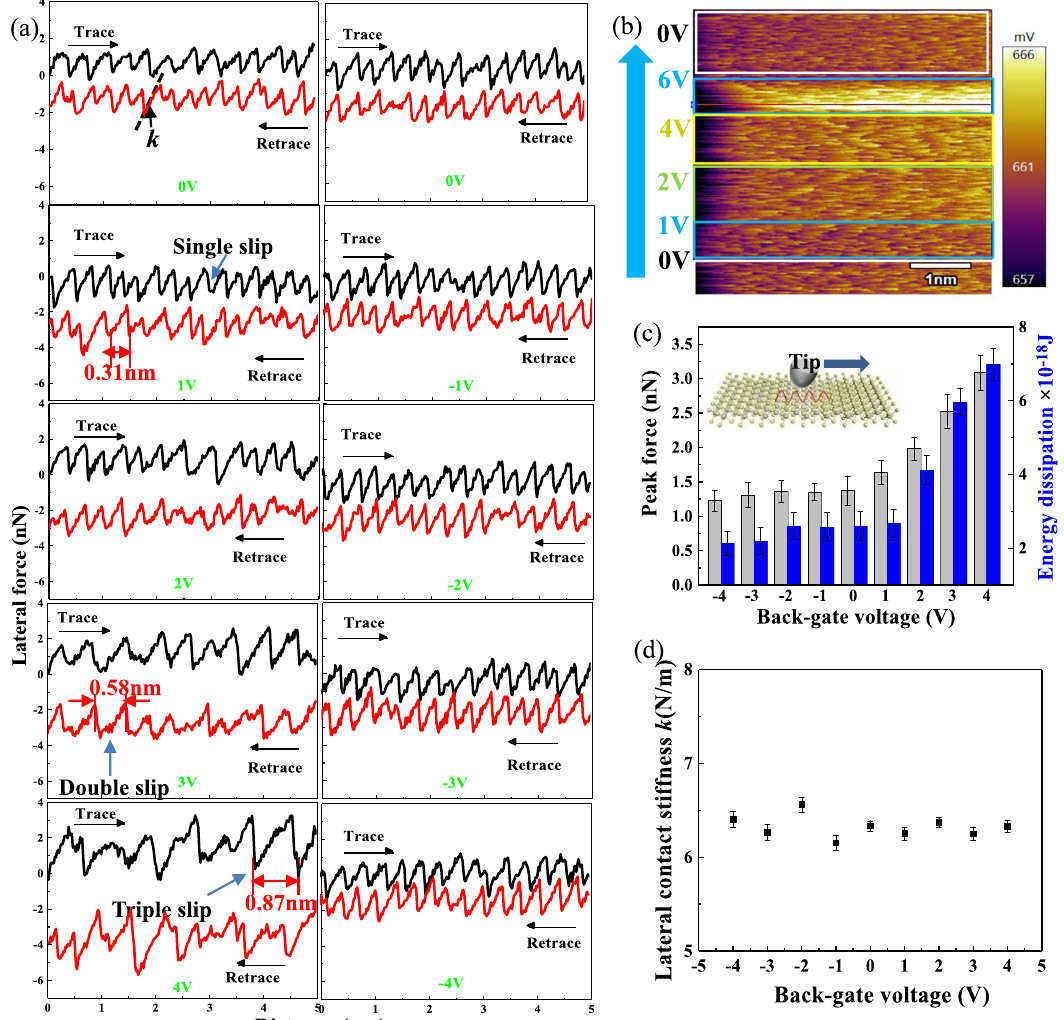
Fig. 3 Atomic-scale friction and stick-slip behavior on atomically thin MoS 2 under different V g . a Stick-slip behavior measured at V g = − 4 – + 4 V, respectively. b Lateral force mapping under different V g : the gate bias voltage was dynamically modulated from 0 V to 6 V and return to 0 V. Scale bar: 1 nm. c Energy dissipation and lateral peak force under different V g . d The lateral contact stiffness k under different V g . Error bars represent standard